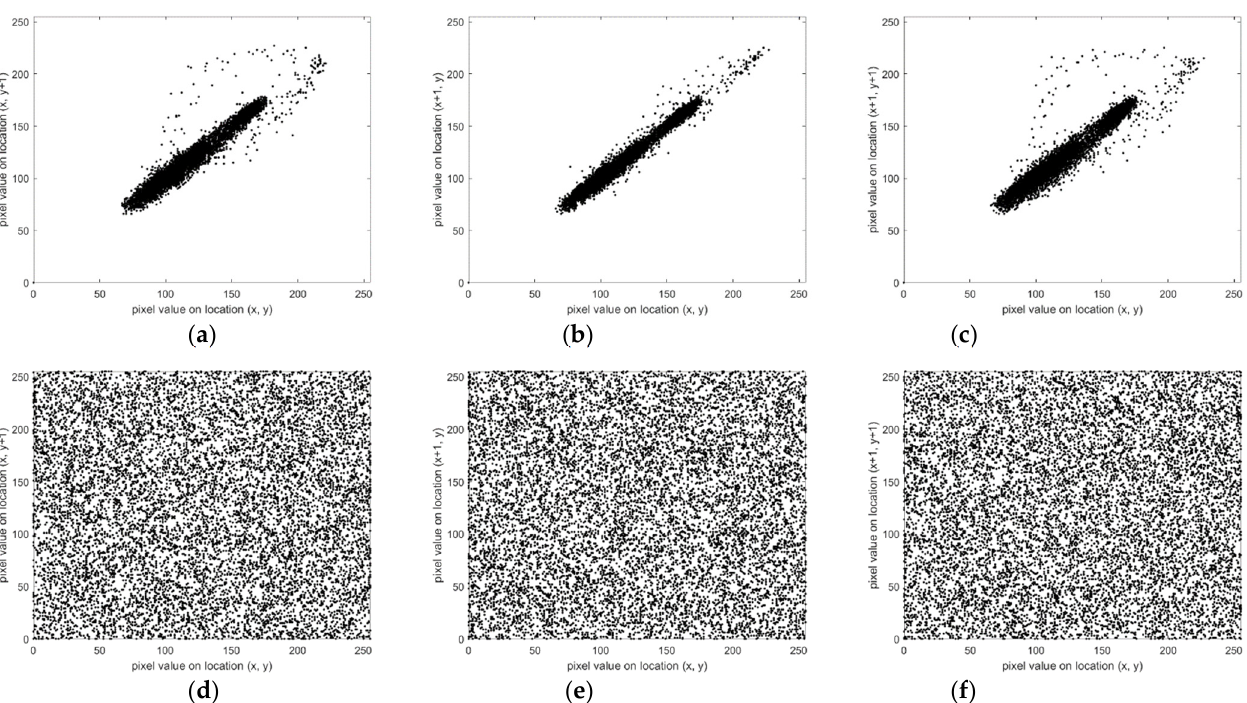
Figure 15. Adjacent pixel correlation of Lena (8BPP) and its corresponding cipher image: ( a ) Horizontal direction; ( b ) Vertical direction; ( c ) Diagonal direction; ( d ) Horizontal direction; ( e ) Vertical direction; ( f ) Diagonal direction.